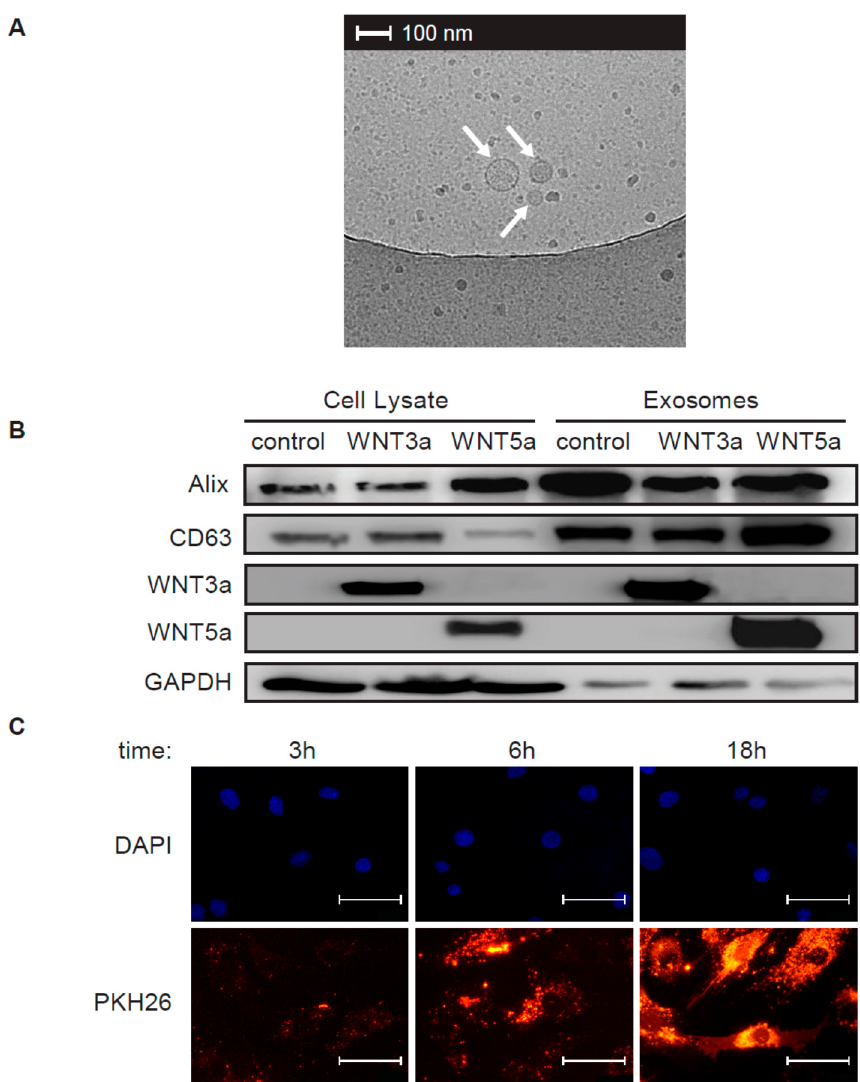
Figure 2. Characteristics of obtained exosomes. Representative transmission electron microscopy (TEM) micrograph showing morphology of exosomes (arrows) is presented in panel ( A ). Immunoblots of exosomal (ALIX, CD63), cytoplasmatic cell (GAPDH) markers, WNT3a and WNT5a proteins in cell lysates and in purified exosomes are presented in panel ( B ). Human cardiac fibroblasts were treated with PKH26-labelled exosomes for 3 h, 6 h, and 18 h. Panel ( C ) shows PKH26-labelled exosomes and cell nuclei (DAPI) at the indicated time point. Bar = 50 µm.